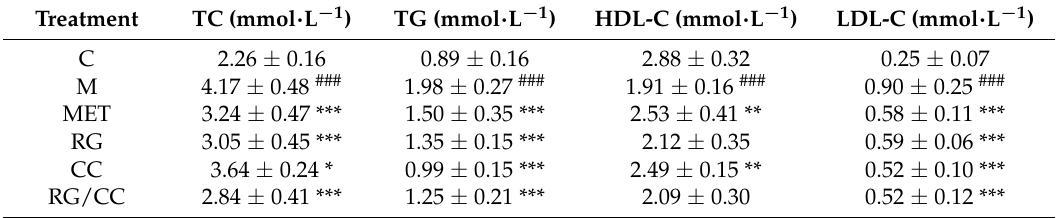
Table 1. Effects of different treatments on serum lipids of diabetic mice after eight weeks of administration.